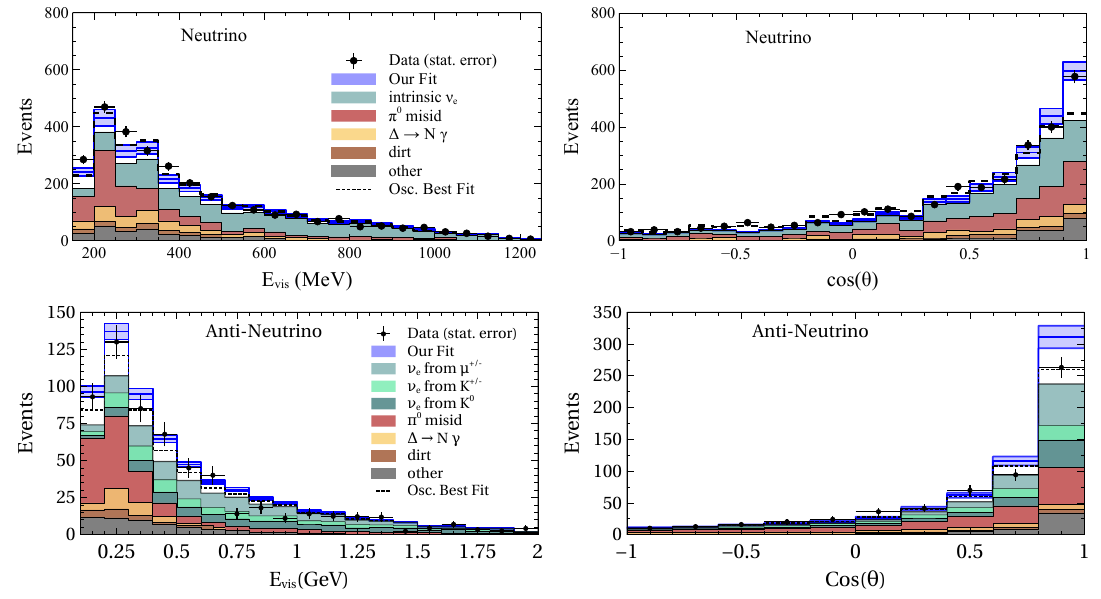
Figure 2 . The MB electron-like events (backgrounds and signal) from [51, 52], versus the vis- ible energy E vis and versus the cosine of the emitted angle of the light, for neutrino (top) and anti-neutrino (bottom) runs. Data points show statistical errors, whereas the blue band shows (estimated) systematic errors. The blue solid line is the prediction of our model. The parameter values used in calculating it are shown in table 1.